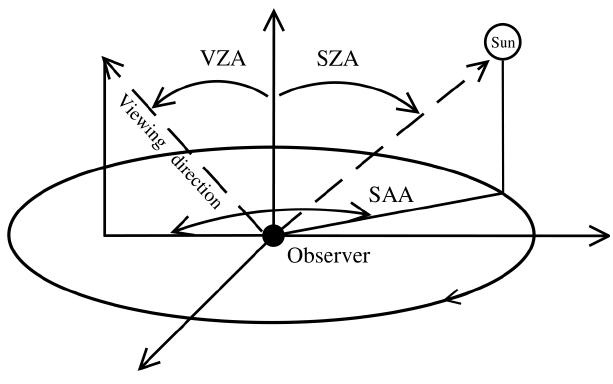
Figure 2. Definition of the viewing geometry in SCIATRAN, with SZA (solar zenith angle), VZA (viewing zenith angle) and SAA (solar azimuth